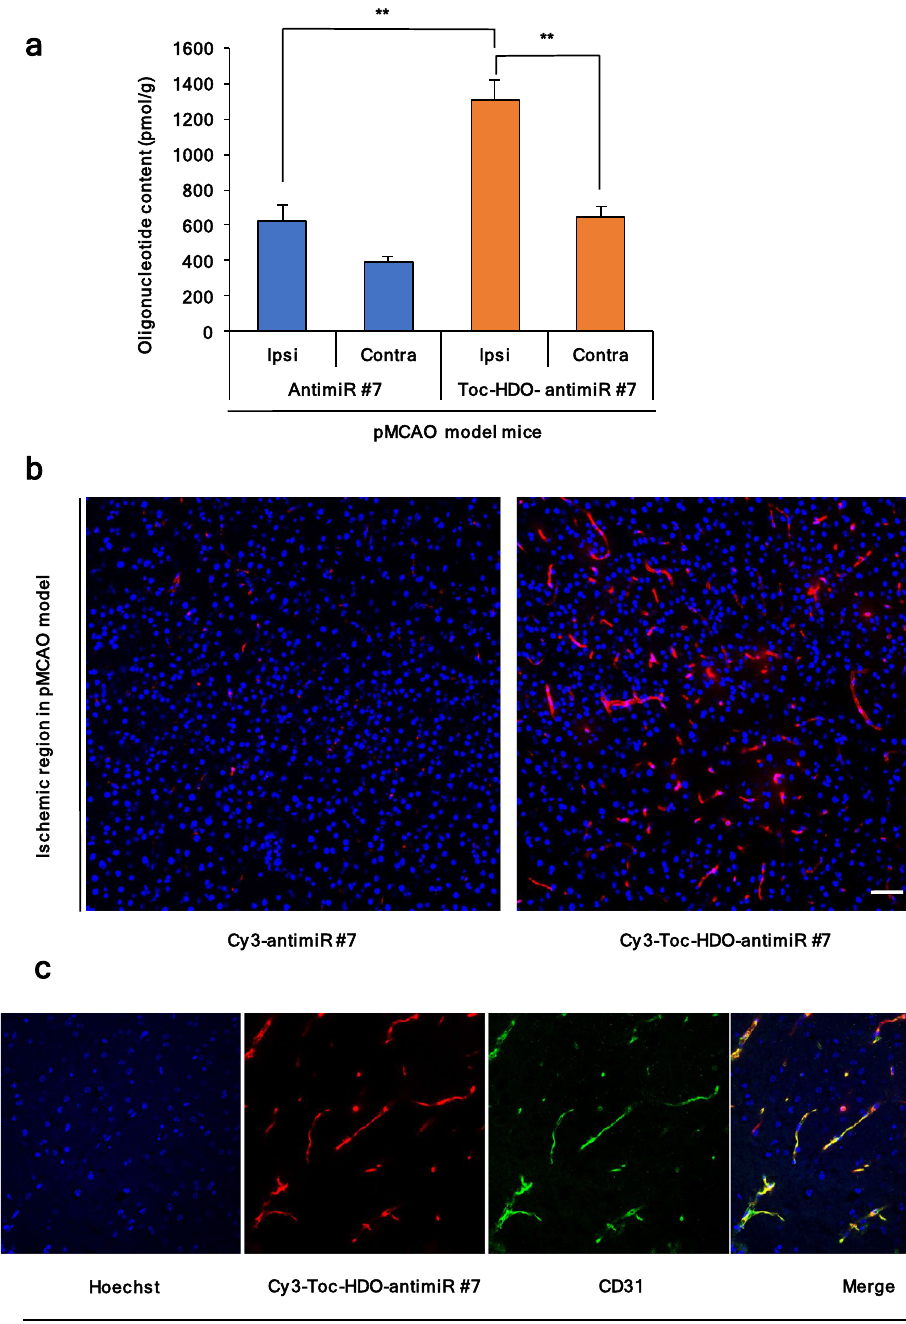
Figure 3. Delivery of Toc-HDO-antimiR #7 in ischemic stroke. ( a ) Oligonucleotide concentrations in the ischemic brain region of the ipsilateral hemisphere (ipsi) and the non-ischemic brain tissue of the contralateral hemisphere (contra) in pMCAO model mice after injection of Cy3-labeled Toc-HDO-antimiR #7 or Cy3- labeled antimiR #7. Data are presented as the mean ± s.e.m (n = 3 per group). ** P < 0.01 versus the ipsi in pMCAO model mice after injection of Cy3-labeled Toc-HDO-antimiR #7 (one-way ANOVA followed by Tukey–Kramer test) ( b ) Confocal laser scanning microscopic images of brain sections in the ischemic region after injection of Cy3-labeled Toc-HDO-antimiR #7 or Cy3-labeled antimiR #7 (red). Scale bar, 50 µm. ( c ) Immunofluorescence images of Cy3-labeled Toc-HDO-antimiR #7 (red) and antibody against endothelial cell marker (anti-CD31; green), and Hoechst staining (blue). Scale bar, 25